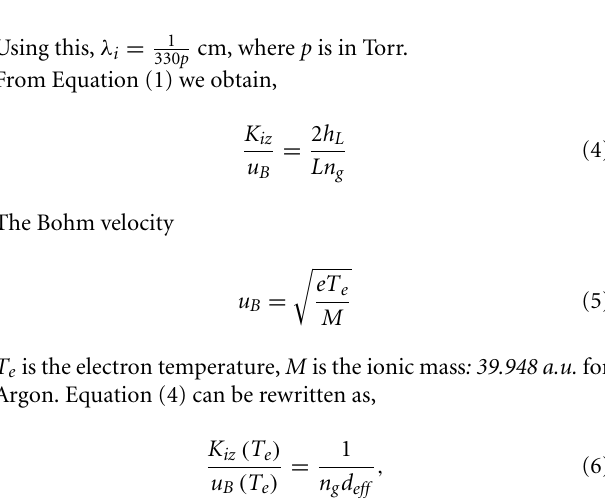
FIGURE 7 | Variation of electron temperature of low and high energy electrons with (A) length, for constant 1 mTorr pressure and (B) pressure, for constant 0.1m length.